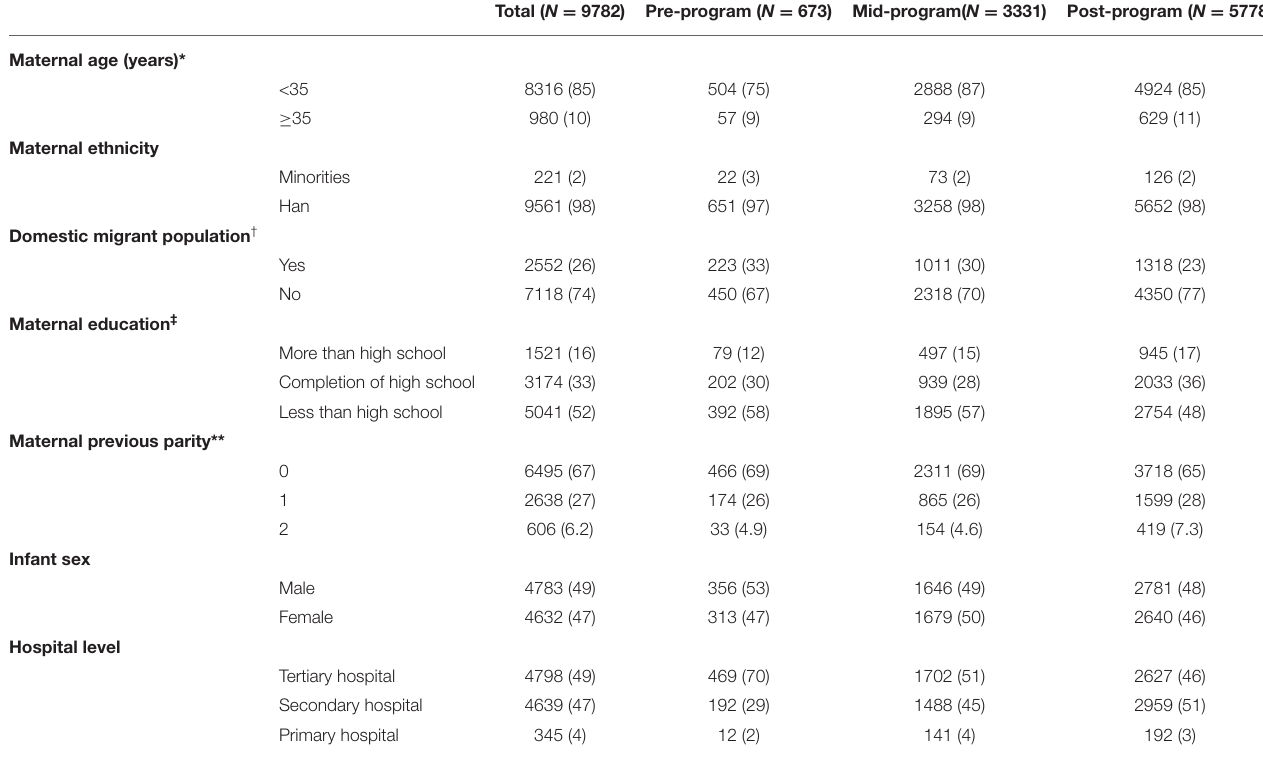
TABLE 1 | Characteristics of congenital heart disease cases,